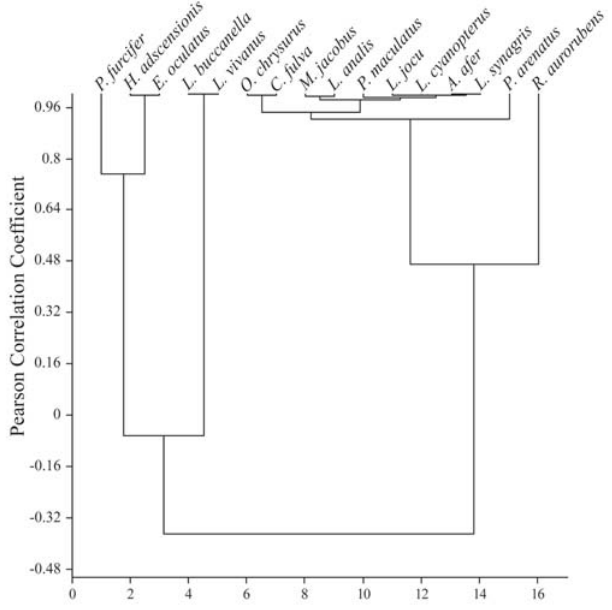
Fig. 4. Similarity dendrogram for the species of the snapper group according to the depth at which they are found, according to the fishermen from Ilhéus, Bahia State, Brazil (number of interviews = 15; for the E.oculatus and P. furcifer n =